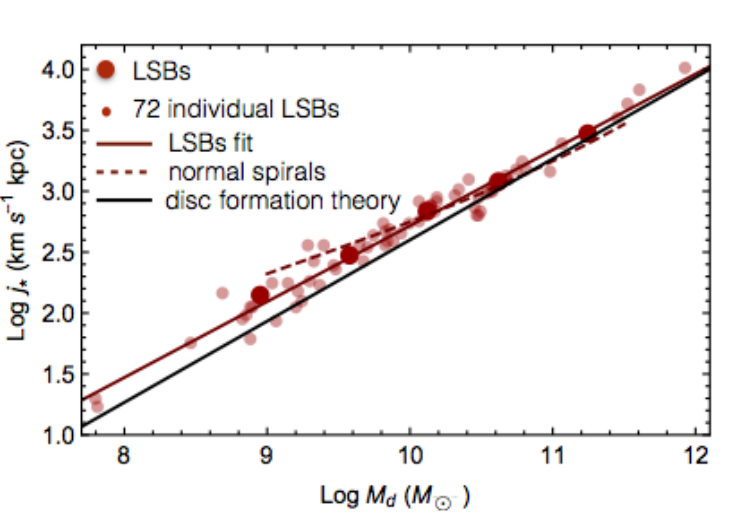
Figure 24. LSBs stellar specific angular momentum-stellar mass (points) and its best fit (solid red line) compared with the spirals relationship (red dashed line) ([180]) and with the relation j (cid:63) ∝ M 2/3 (black line) by [251]. Image reproduced from [207] (Figure